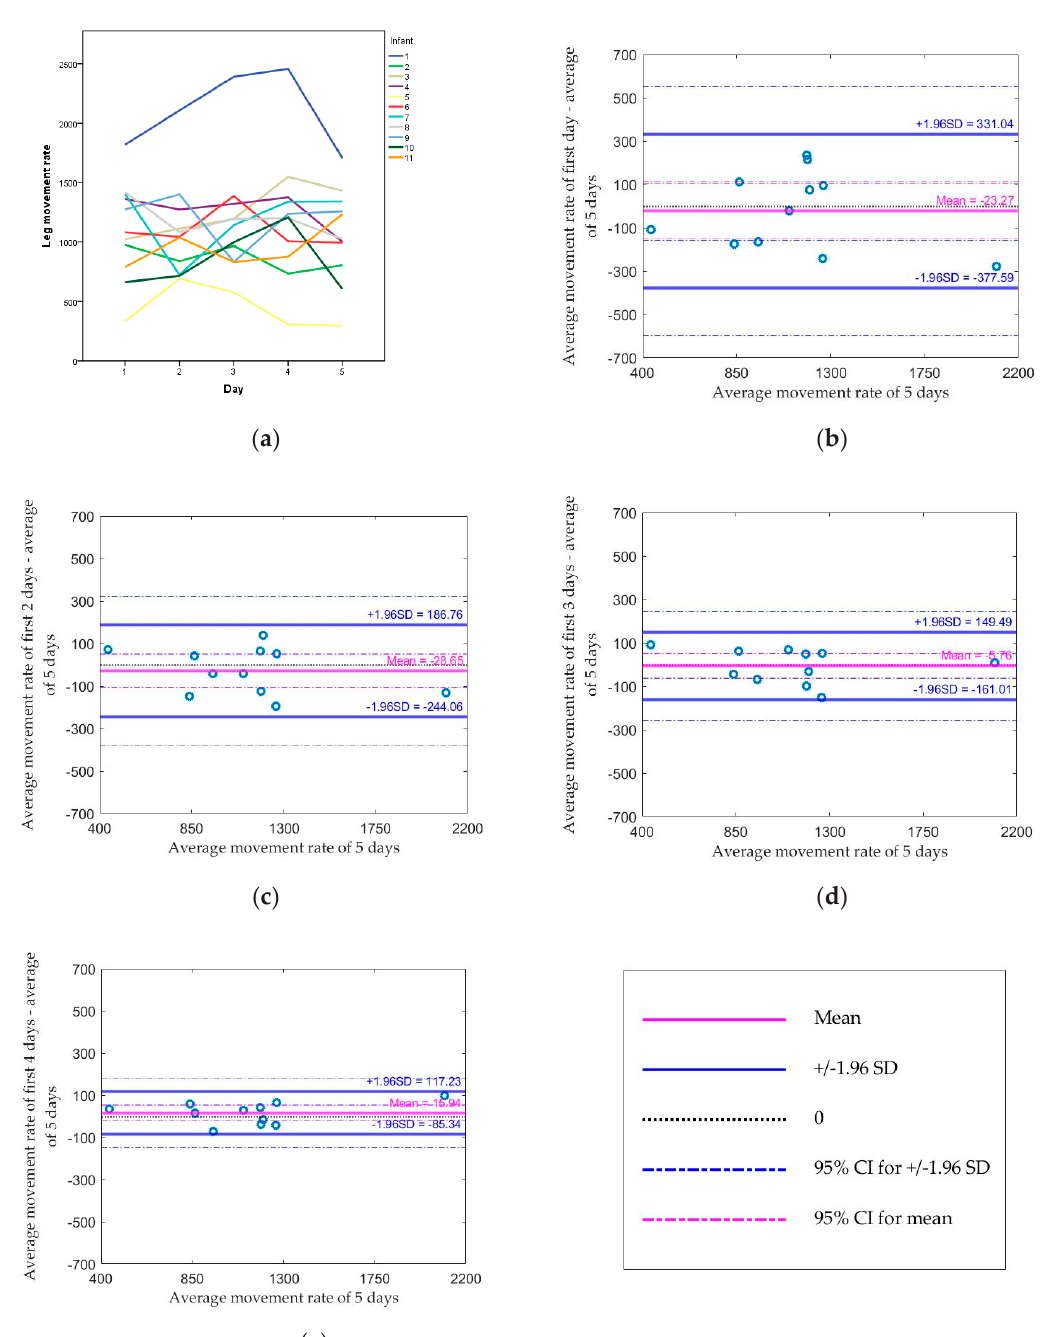
Figure 1. ( a ) Average leg movement rate (average leg movements per hour awake time) from the first day to the fifth day for each infant; Bland–Altman plots comparing ( b ) the first day, ( c ) the average of the first 2 days, ( d ) the average of the first 3 days, ( e ) the average of the first 4 days, and the average of 5 days for the average leg movement rate.